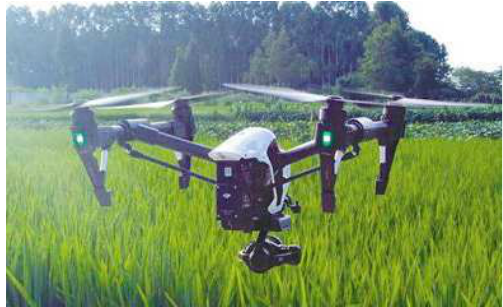
Figure 10. Hyperspectral sensor on-board a DJI T600 unmanned aerial vehicle